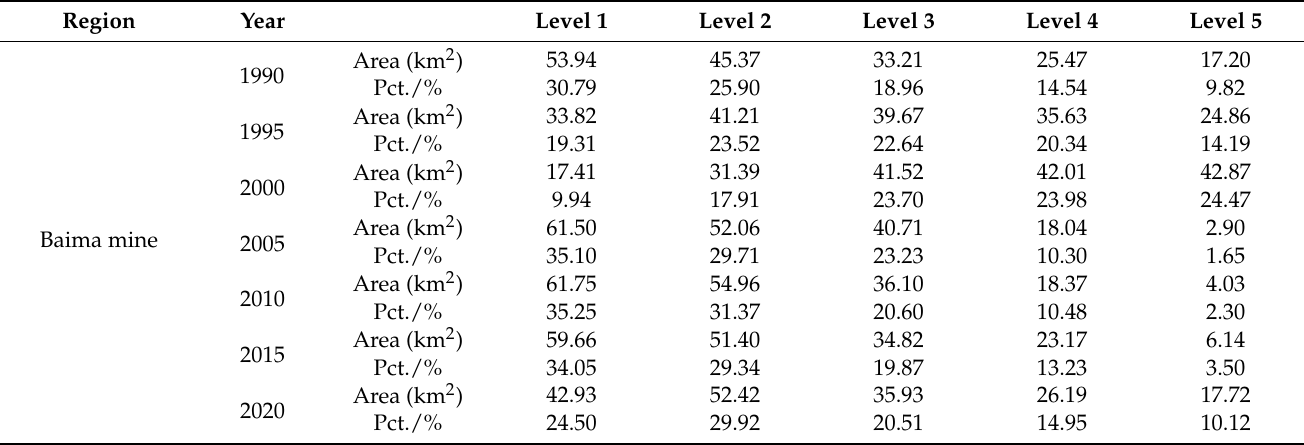
Figure A4. Land-use map of Panzhihua City. Table A1. RSEI Classification Results for Three